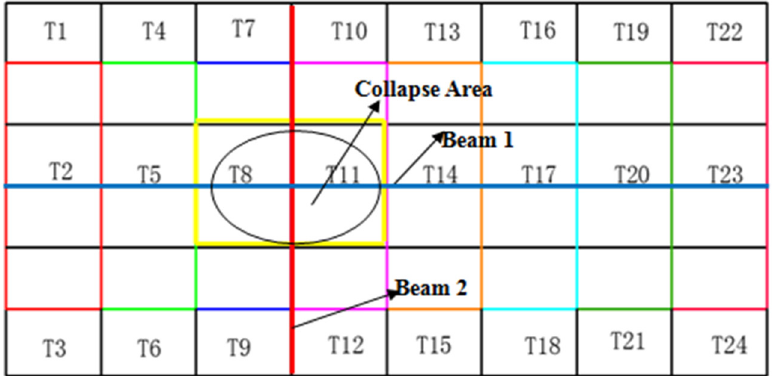
Figure 22. Model in ABAQUS .